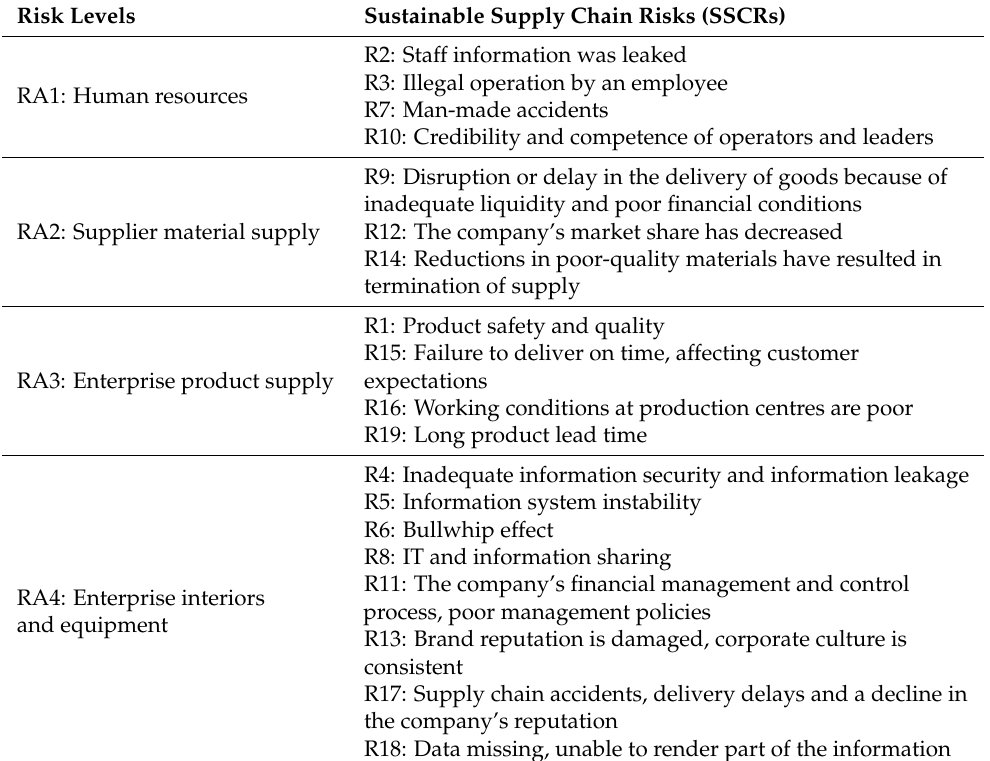
Table 5. Key SSCRs analysis hierarchy. Risk Levels